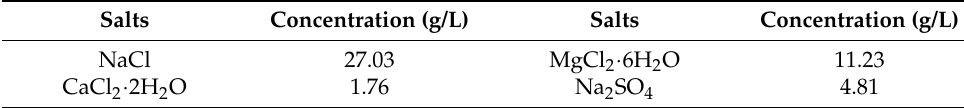
Table 1. Composition of synthetic seawater.